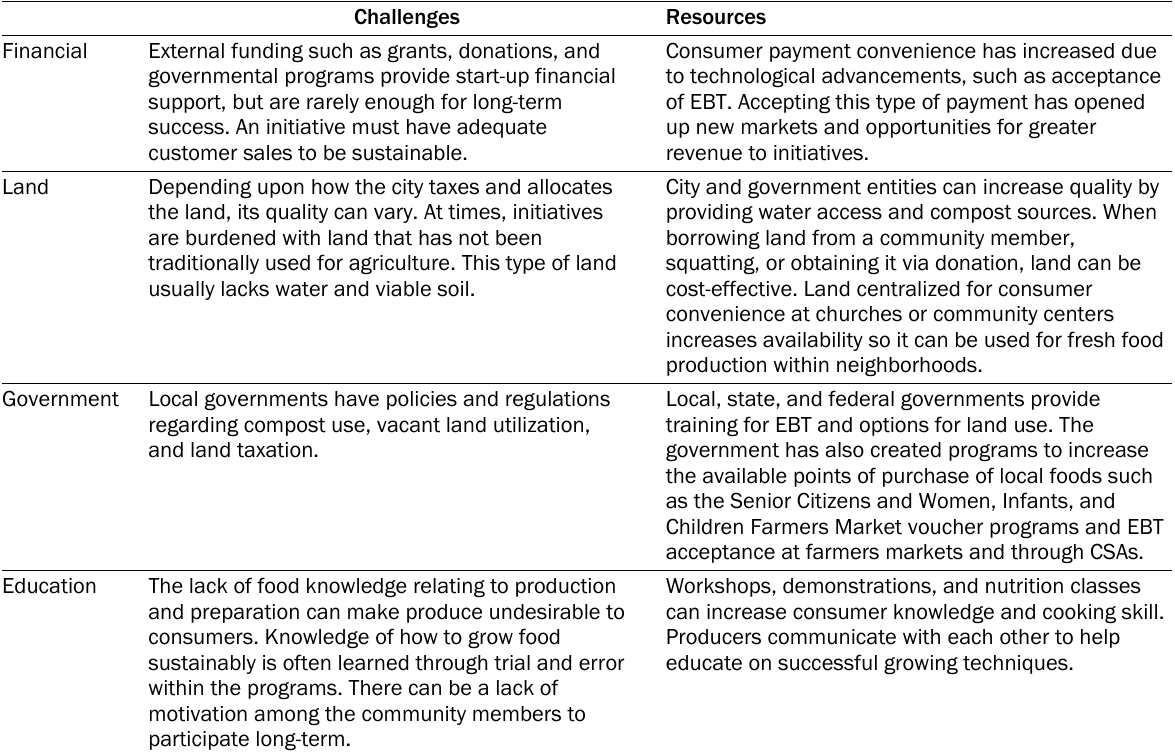
Table 3. Challenges and Resources Identified with a Community Food Security